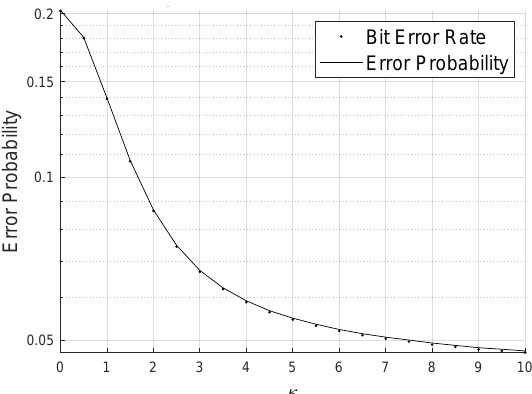
Figure 8. Error probability varying the Von Mises concentration parameter.